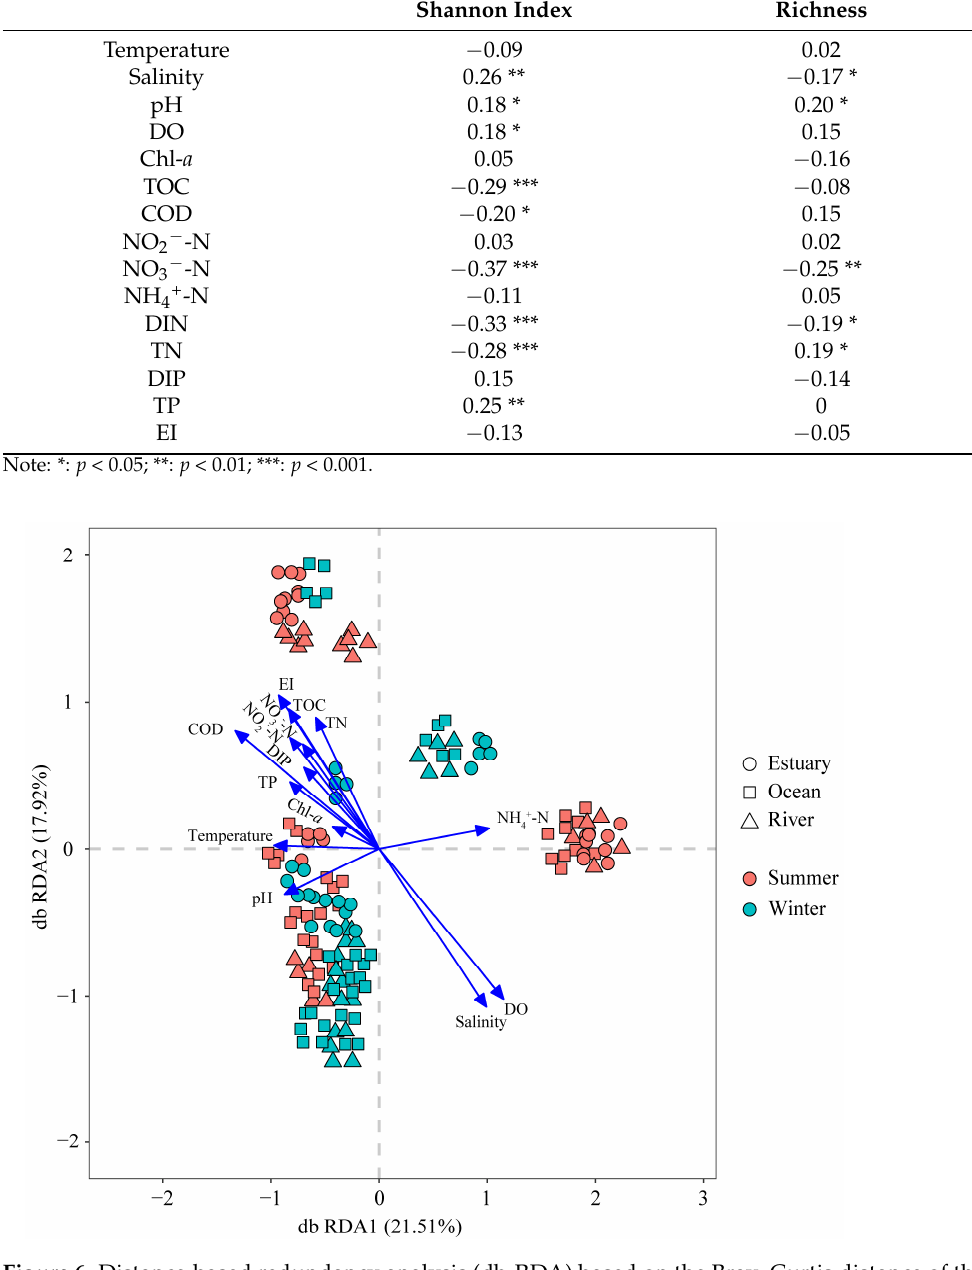
Figure 6. Distance-based redundancy analysis (db-RDA) based on the Bray–Curtis distance of the mycoplanktonic community in relation to the environmental factors.